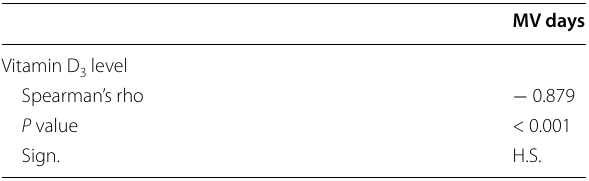
level and mechanical 3